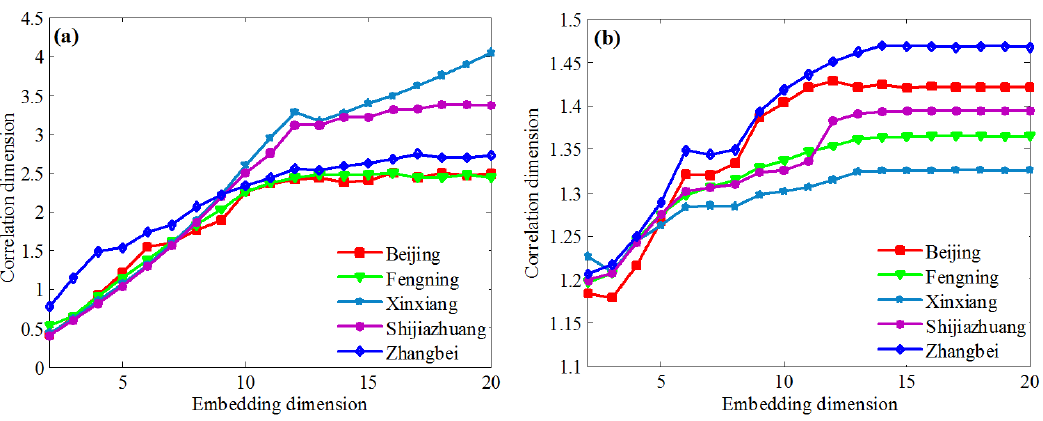
Figure 7. Variation of correlation dimension vs. embedding dimension of climate variables: (a) precipitation and (b) air